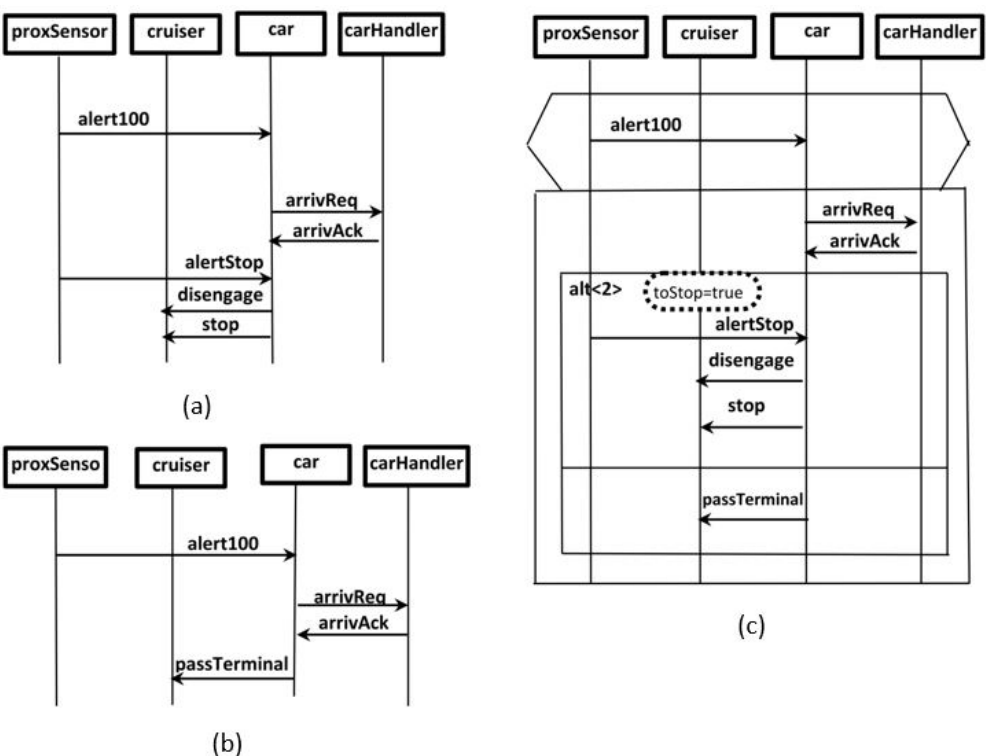
Figure 3. A portion of a railcar system case study is described in two sequence charts, combined by s-TS into one chart. ( a ) Simple sequence chart describing scenario of car approaching terminal with stopping at terminal. ( b ) Another simple sequence chart describing scenario of car approaching terminal with passing that terminal. ( c ) One s-TS combining the two scenarios described in ( a , b